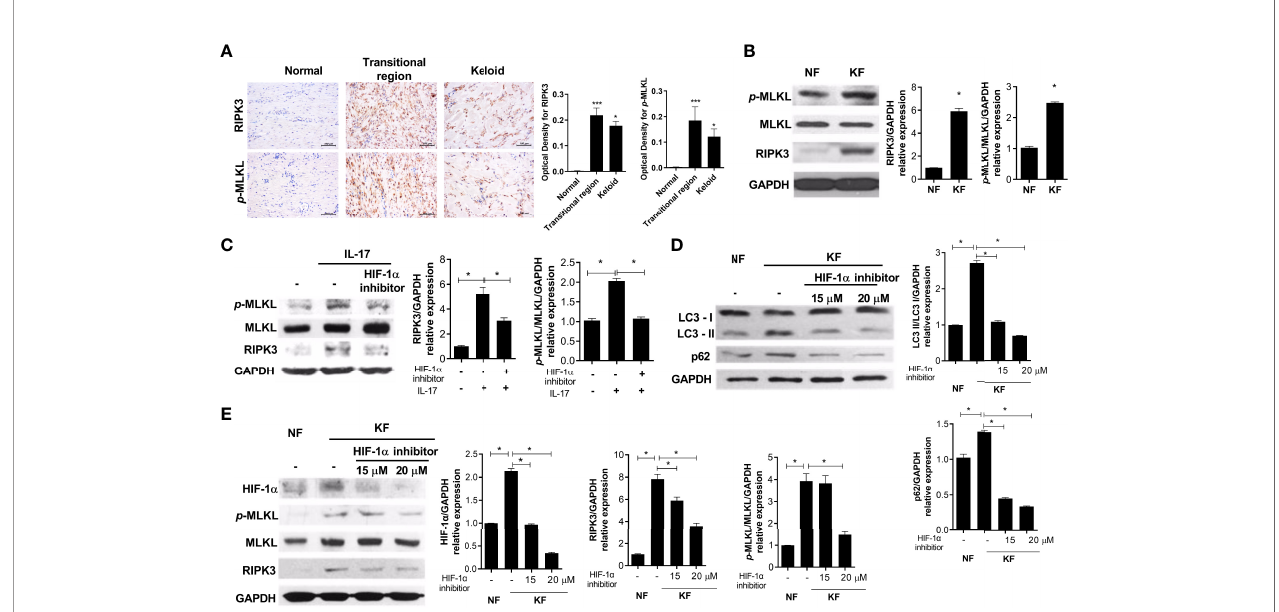
FIGURE 4 | IL-17 induced necroptosis and fi brosis via HIF-1 a . (A) RIPK3 and p -MLKL were analyzed by IHC in keloid tissues. (B) Protein levels of p -MLKL, MLKL, RIPK3, and GAPDH in NF and KF. (C) NF was cultured with IL-17 (10 ng/mL) and HIF-1 a inhibitor (20 m M) for 48h. Indicated proteins were detected using western blot. (D, E) Protein levels of LC3I, LC3II, p62, HIF-1 a , p -MLKL, MLKL, RIPK3 and GAPDH were analyzed in lysates of NF and HIF-1 a -inhibitor-treated KF. Bar graph shows data from one of three independent experiments; results are means ± SD of three independent experiments per group (* P < 0.05, *** P < 0.001).